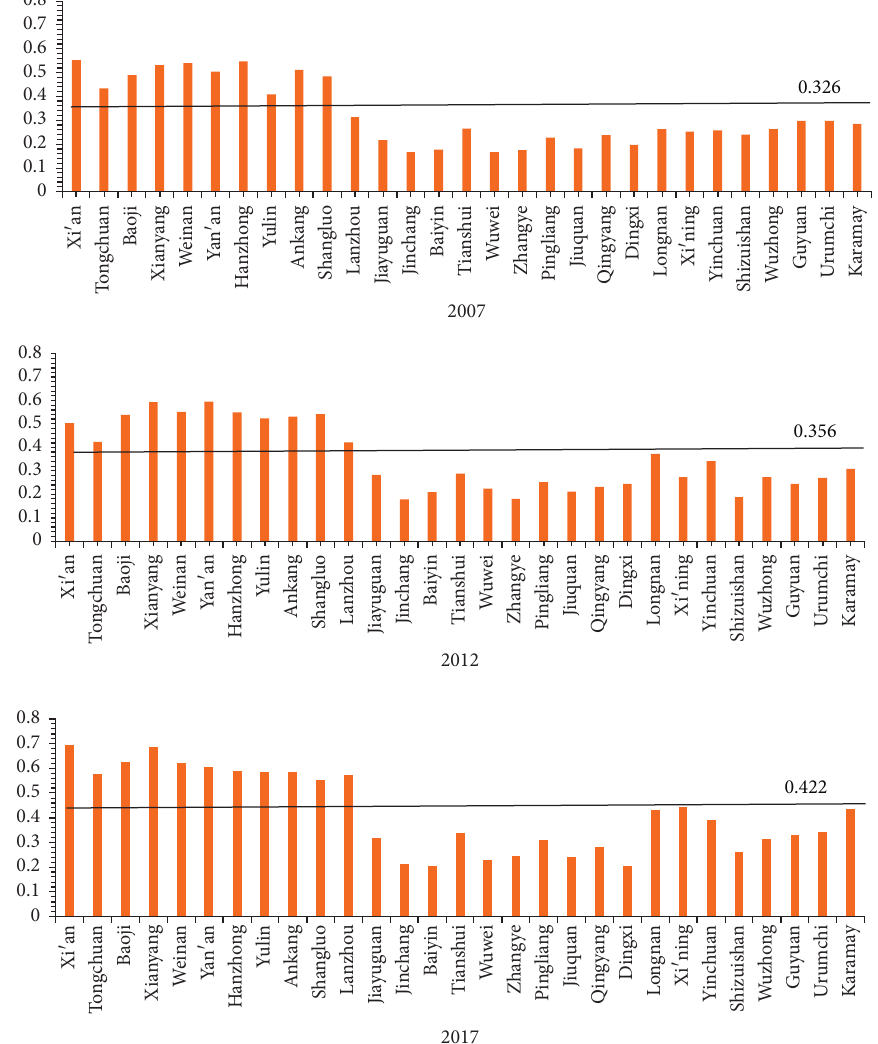
Figure 3: Green development efficiency of prefecture-level cities in Northwest China in 2007, 2012, and